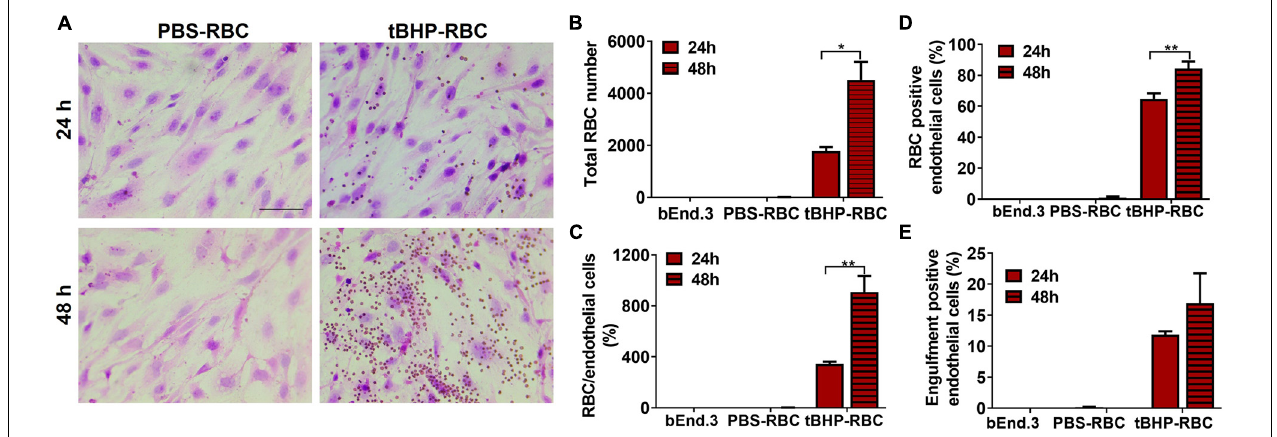
FIGURE 2 | Temporal increase in brain endothelial erythrophagocytosis. Significant time-dependent increase in adhesion (A–D) and a trend toward increased engulfment (E) of tBHP-RBCs compared with PBS-RBCs using H&E staining and light microscopy. RBCs are seen as small red/brown dots, and bEnd.3 nuclei are stained purple with hematoxylin in A. Data are presented as mean ± SEM of three independent experiments done in duplicates. Two-way ANOVA with Holm–Sidak post hoc test was used. * p < 0.05, ** p < 0.01. Scale bar = 50 µ